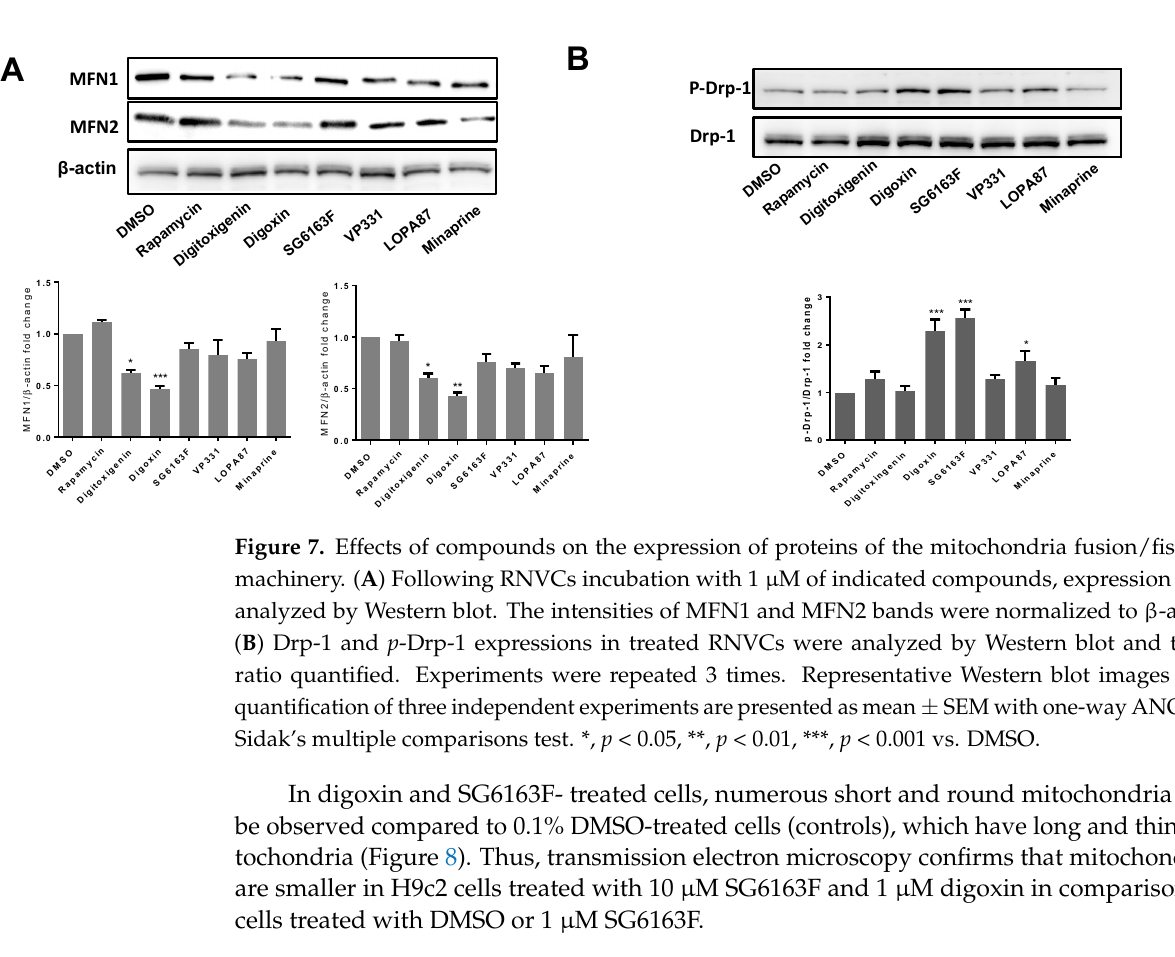
Figure 6. Effect of selected compounds on mitochondrial volume. RNVCs were treated with 1 µM compounds for 6 h and labeled with 4 µM calcein to determine the effect of compounds on the mitochondrial volume ( A ). Mitochondria were labeled with 200 nM Mitotracker to evaluate the total volume of mitochondria per cell ( B ) and quantify the number of individual mitochondria per cell ( C ). At least 150 cells were analyzed using a Leica confocal microscope and IMARIS software. Data are presented as mean ± SEM with one-way ANOVA, Sidak’s multiple comparisons test. *, p < 0.05,